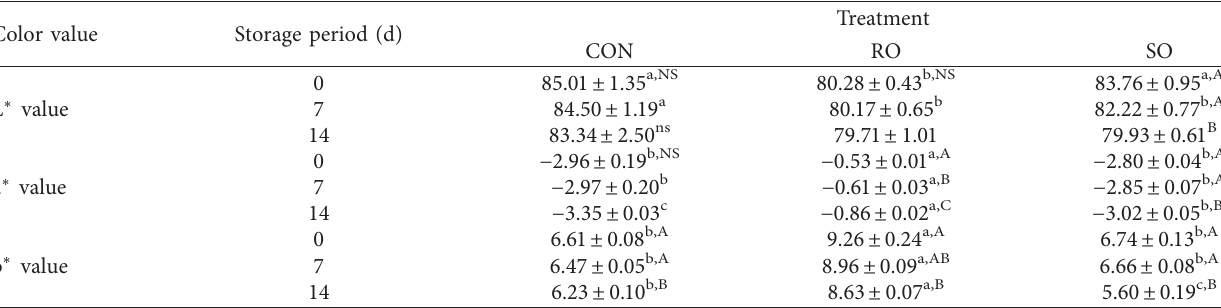
Table 3: Color during the storage of yogurts.